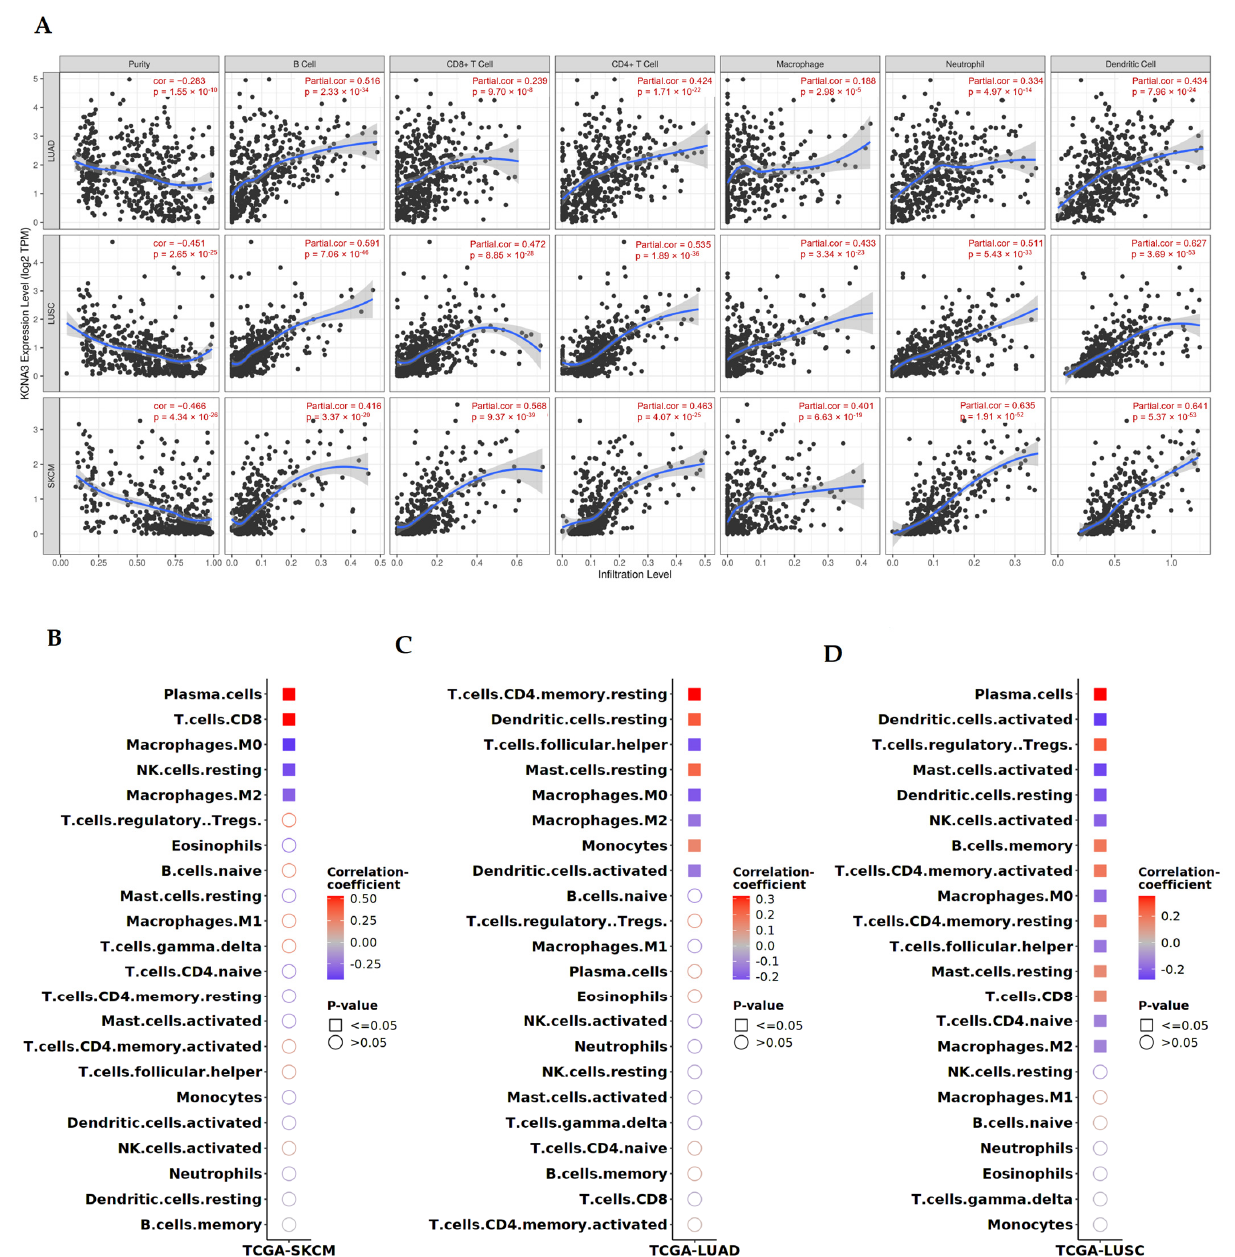
Figure 5. KCNA3 correlation with infiltrating immune cells and prognostic value in SKCM, LUAD, and LUSC. ( A ) Correlation between KCNA3 level of expression and immune infiltration cell types was obtained in the overall LUAD, LUSC, and SKCM TCGA dataset using the TIMER database. Significance and correlation values are shown. ( B – D ) Correlation between KCNA3 level of expres- sion and immune infiltration in SKCM ( B ), LUAD ( C ), and LUSC ( D ), retrieved from the respective TCGA datasets employing the Survival Genie database tool. Significance and correlation coefficient are shown in the graphs.